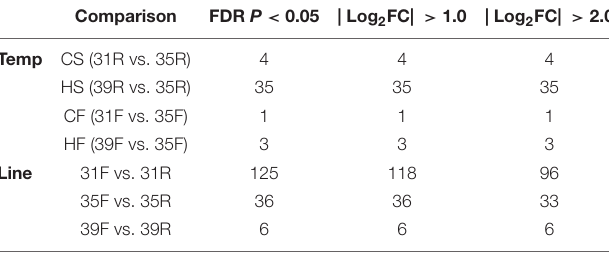
TABLE 2 | Numbers of differentially expressed circRNAs (DECs) in pairwise comparisons 1 .